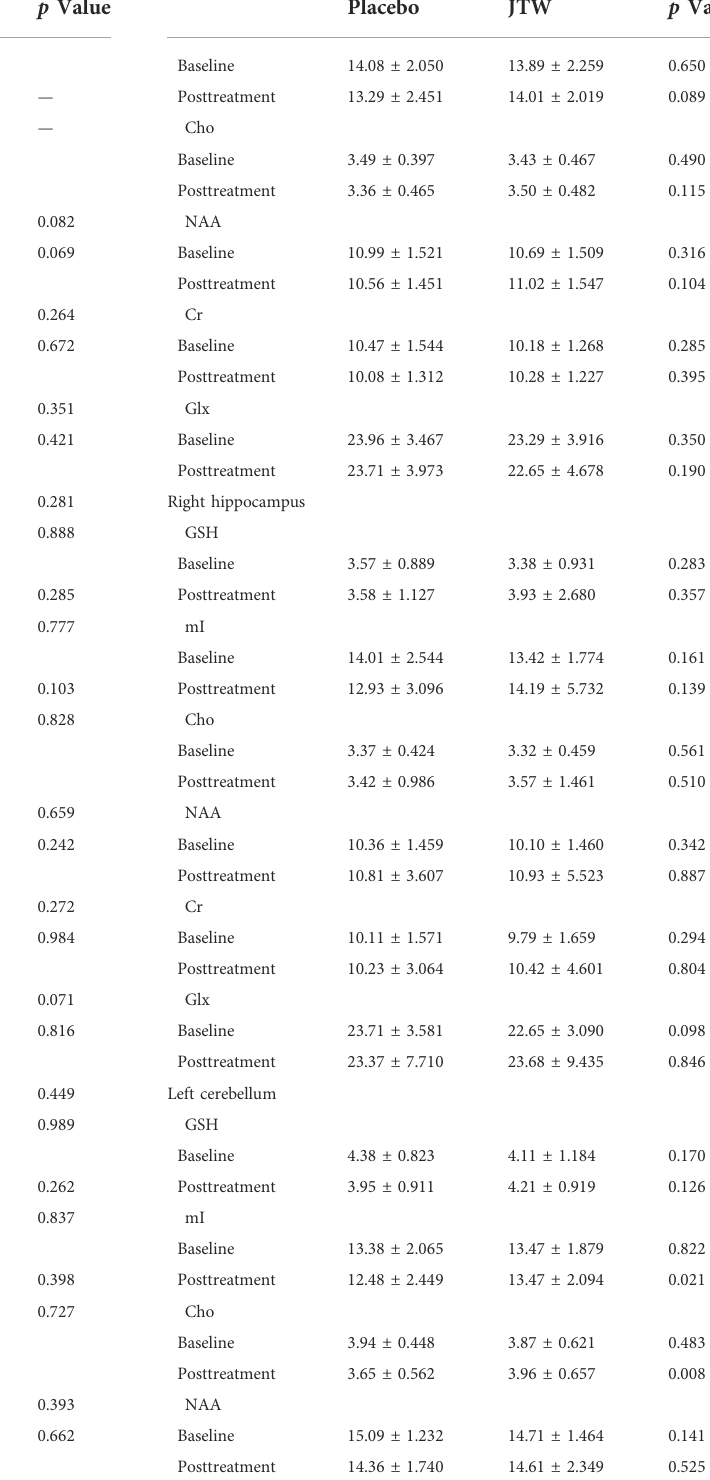
TABLE 4 ( Continued ) Analysis and comparison of 1 H-MRS in the participants at baseline and posttreatment between the JTW and placebo